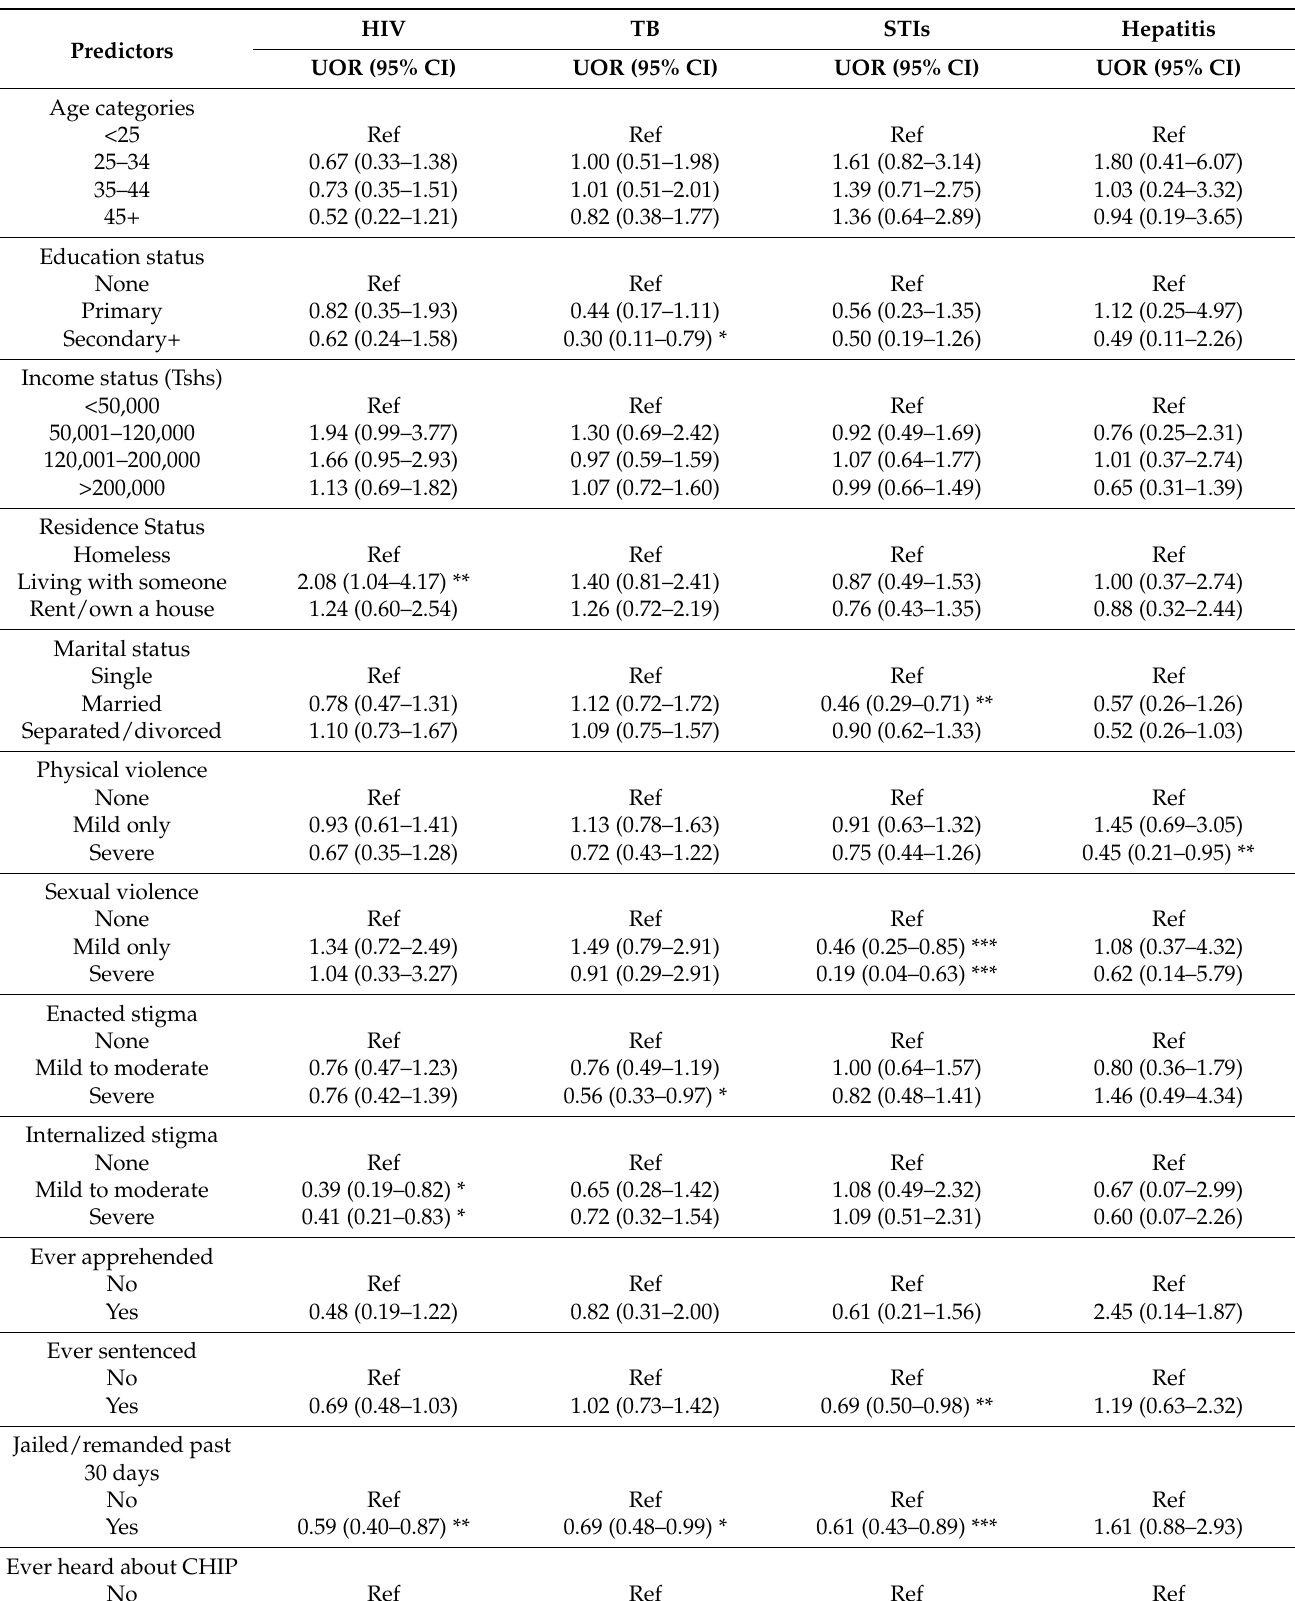
Table 3. Results of bivariate analyses of the associations between predictors and access to testing for drug-related infectious diseases among people who inject drugs in Dar es Salaam and Tanga ( n =